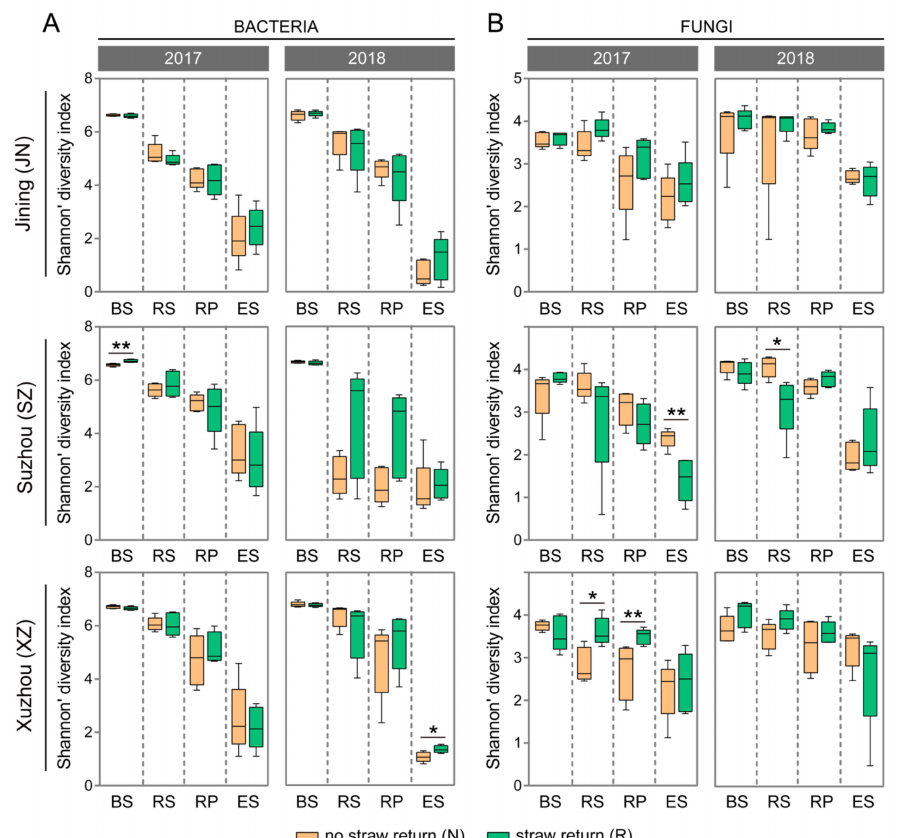
Figure 1. The influence of WSR on α -diversity (Shannon’s diversity index) for bacterial ( A ) and fungal ( B ) communities within each site, year, and compartment. Horizontal bars in boxes are medians; upper and lower box edges are the 75th and 25th quartiles, respectively; and whiskers are 1.5-fold the interquartile range. Based on Wilcoxon rank-sum test, significant differences between treatments within a compartment are indicated with “*” ( p < 0.05) or “**” ( p < 0.01).